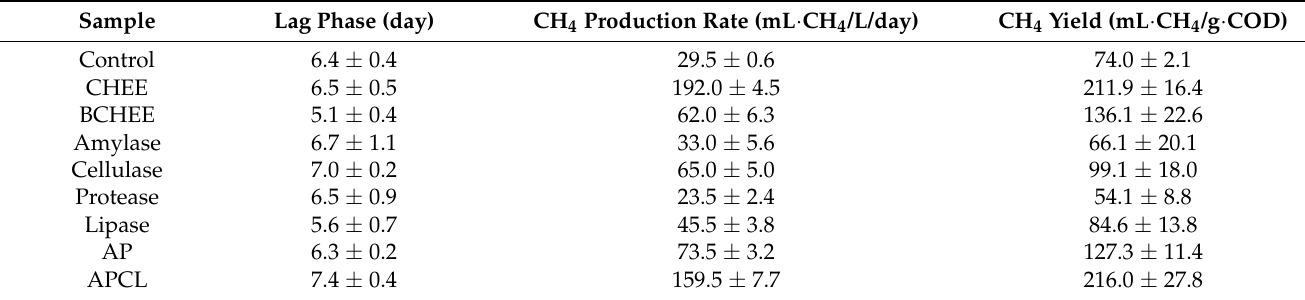
Table 1. Effect of enzymatic pretreatments using crude hydrolytic extracellular enzyme and commer- cial enzyme on batch test I of waste activated sludge for CH 4